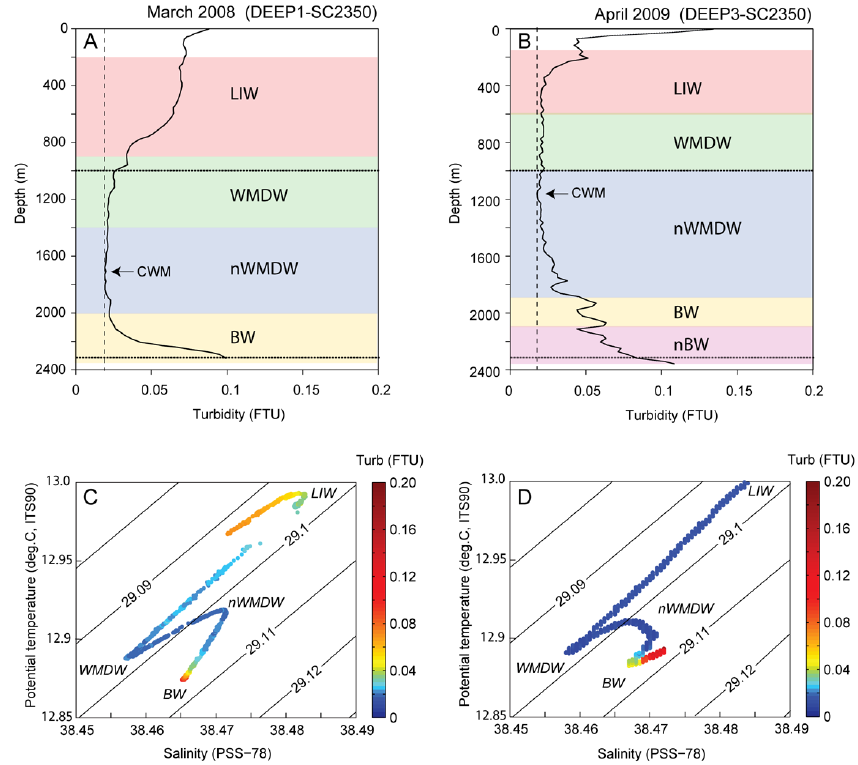
Fig. 9. Turbidity profiles from CTD casts performed in the vicinity of the SC2350 site in March 2008 (A) and May 2009 (B) . The clear water minimum (CWM) that defines the upper limit of the bottom nepheloid layer is around 1600–1800-m depth in 2008 and 1200-m depth in 2009. The major water masses LIW (Levantine Intermediate Water), WMDW (old western Mediterranean Deep Water), nWMDW (new western Mediterranean deep Water), BW (bottom water) are indicated. The horizontal dotted lines indicated the depth of the sediment traps on the SC2350 mooring line. Associated potential temperature-salinity diagrams in March 2008 (C) and May 2009 (D) where in color indicated the turbidity (in